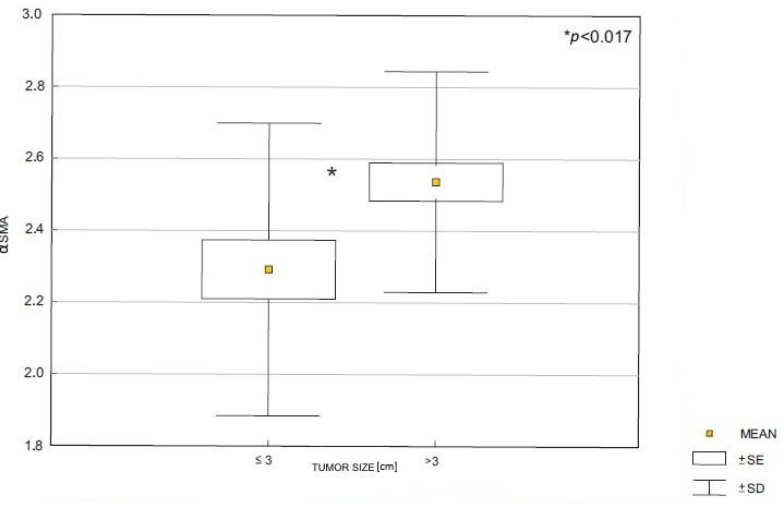
Figure 6. Comparison of α SMA expression in tumors > and ≤ 3 cm.